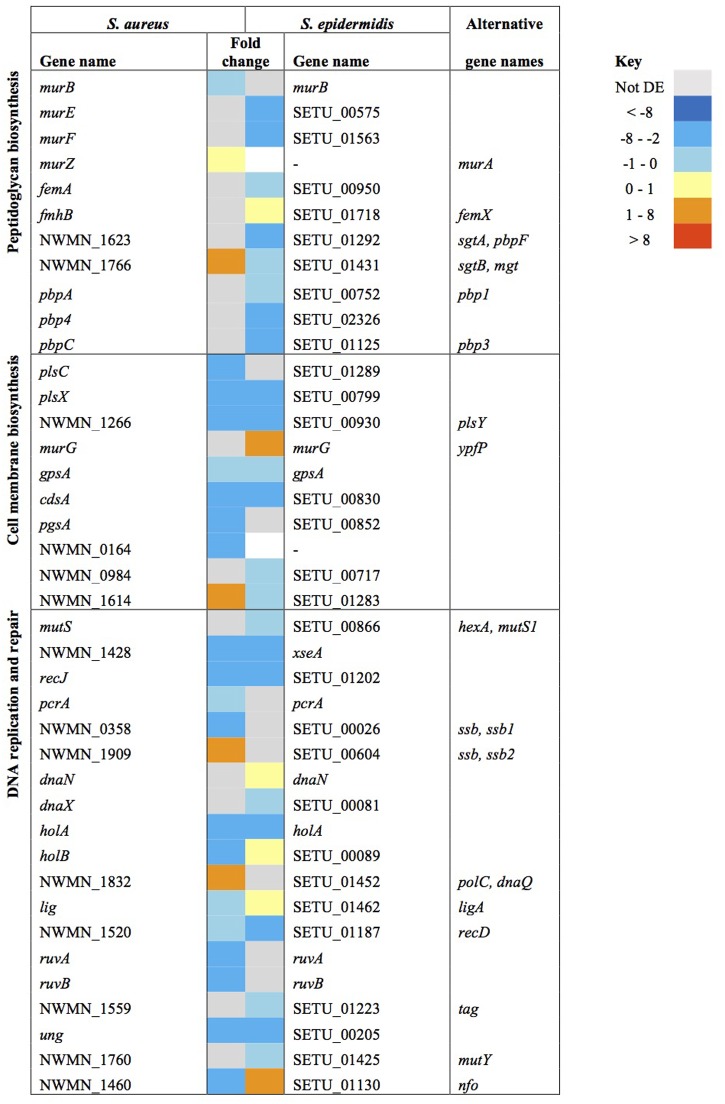
Changes in gene expression of growth associated genes in S. aureus and S. epidermidis challenged with sapienic acid.